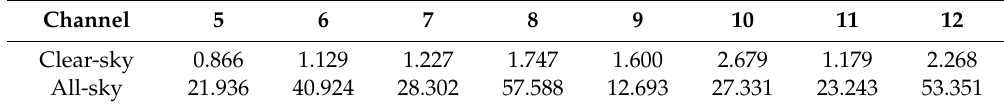
Table 2. Observation errors (K) for AMSR2 [25].